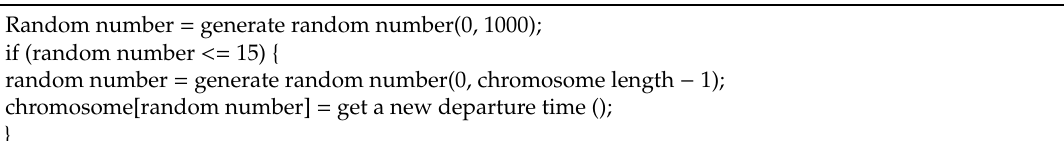
Table 11. Pseudocode for mutation